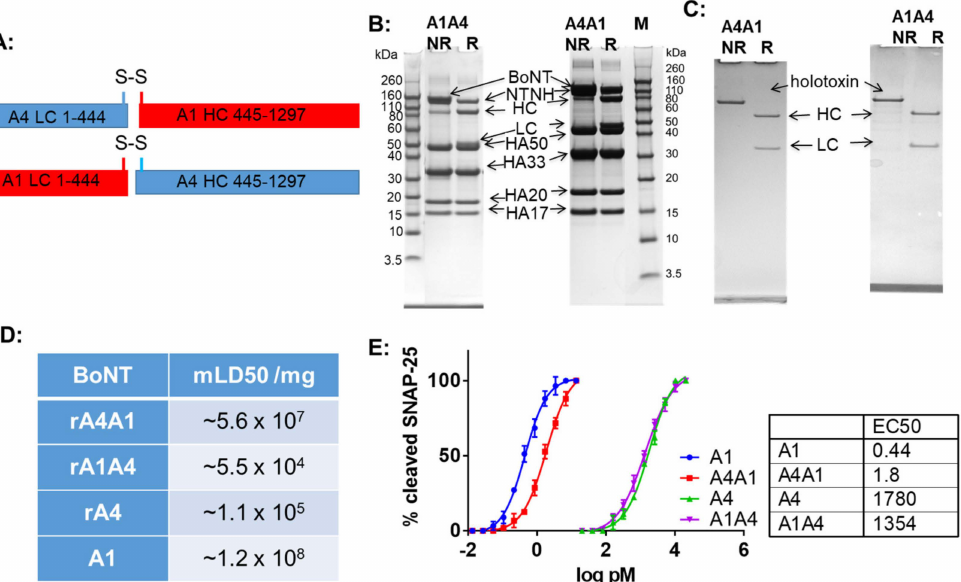
Figure 1. Purified BoNT/A1 and /A4 LC-HC chimeras and biologic activity. The chimeric BoNTs were expressed in C. botulinum strain Hall A hyper/tox - and purified using biochemical methods. ( A ) schematic showing the chimera design. ( B ) Comassie stained SDS-PAGE gels of nonreduced (NR) and reduced (R) samples of isolated BoNT/A1A4 and /A4A1 toxin complexes. The complexing proteins are indicated. ( C ) Comassie stained SDS-PAGE gels of nonreduced (NR) and reduced (R) samples of purified BoNT/A4A1 and BoNT/A1A4. ( D ) Specific toxicity of wt and chimeric BoNT/A1 and /A4 in mice. ( E ) Potency of wt and chimeric BoNT/A1 and /A4 in cultured human induced pluripotent stem cell derived neurons. n = 3.